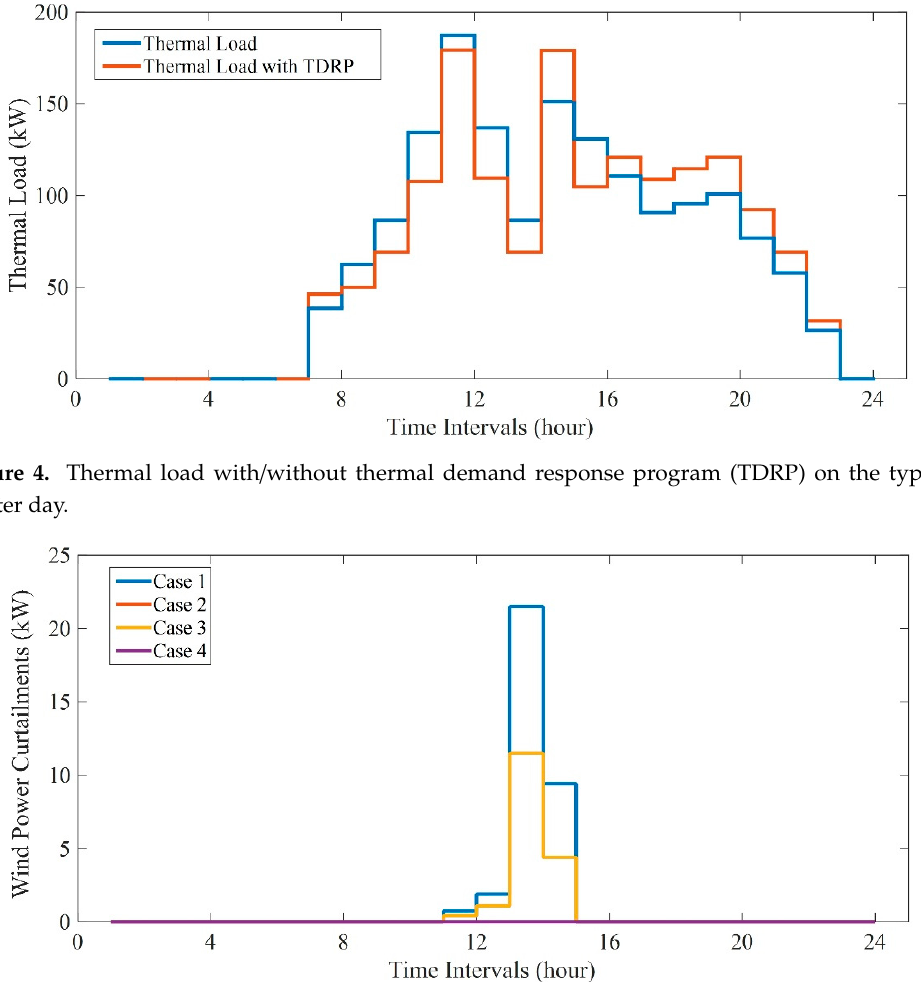
Figure 5. The wind power curtailment in Cases 1–4 on the typical winter day.